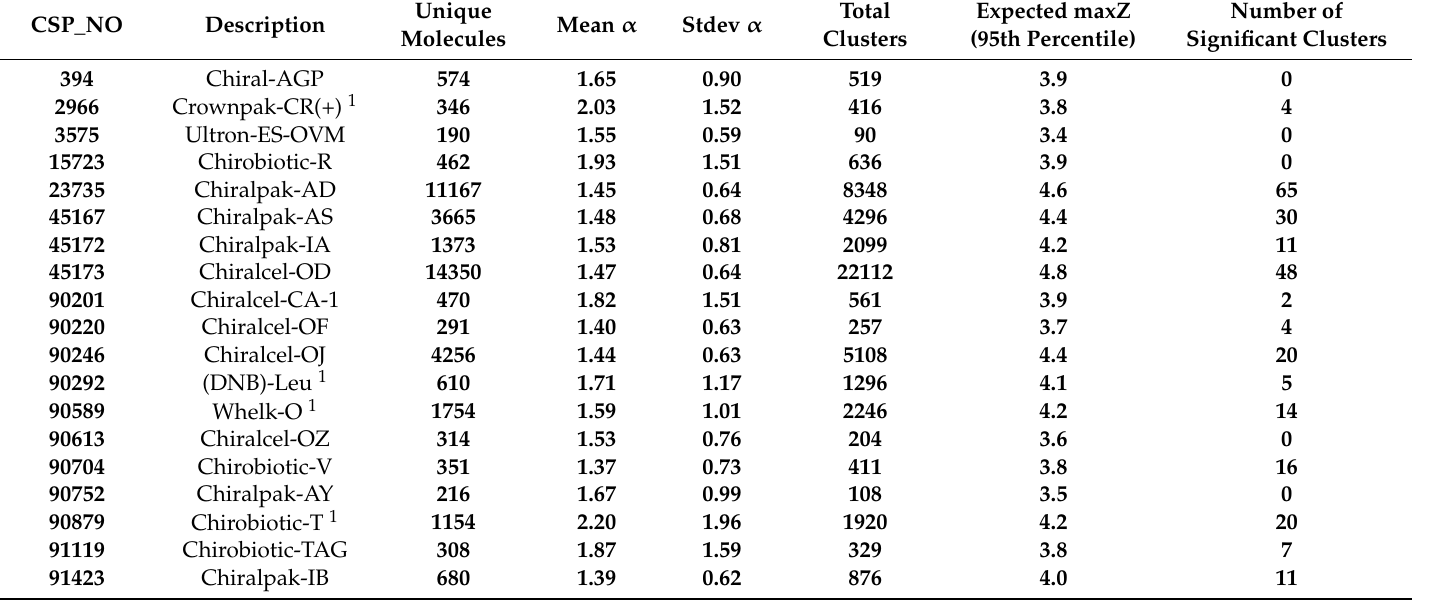
Table 1. Stationary Phase in Chirbase Studied in this